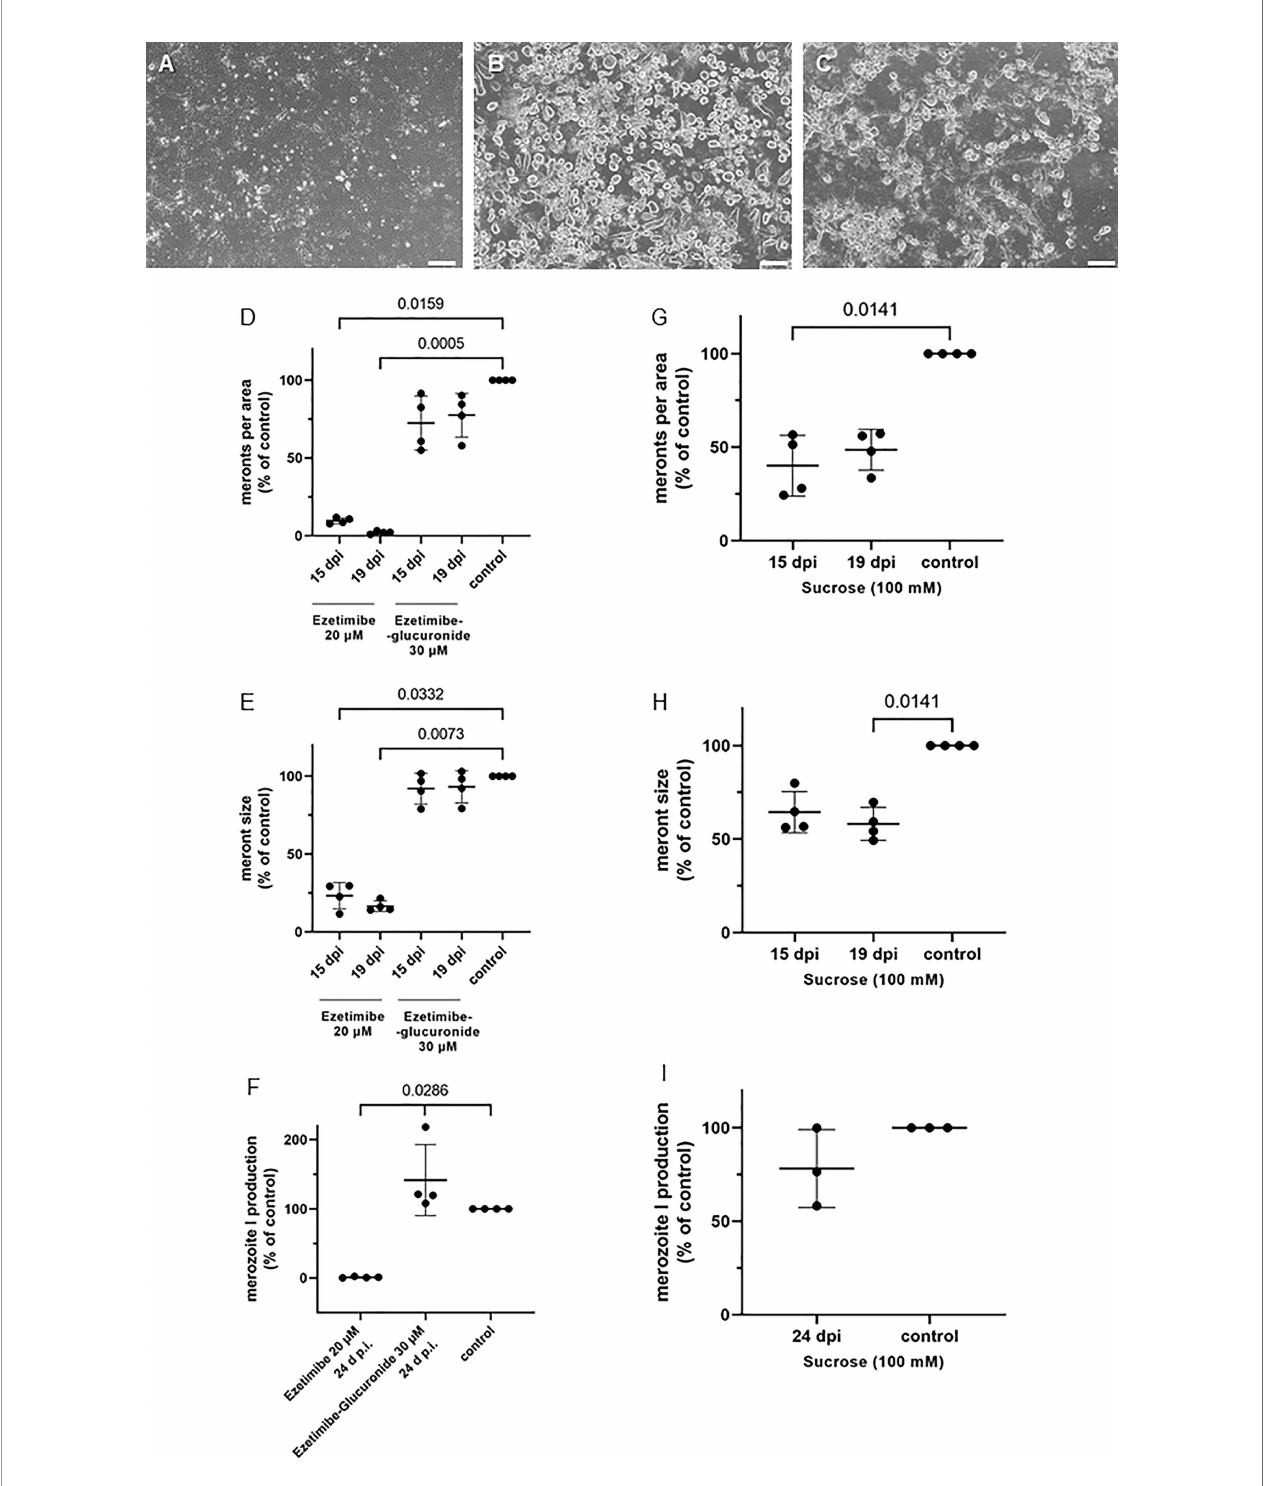
FIGURE 7 | Effects of ezetimibe, ezetimibe-glucuronide and sucrose treatments on E. bovis development. (A) ezetimibe treated-, (B) control- and (C) sucrose treated- E. bovis -infected BUVEC (3-4 biological replicates with technical duplicates) at 19 d p. i. Number of meronts I (D, G) and meront I size (E, H) were calculated at 15 and 19 d p. i., and merozoite I production (F, I) was determined at 24 d p. i. Results are expressed as percentage of untreated controls (100%). Scale bar 200